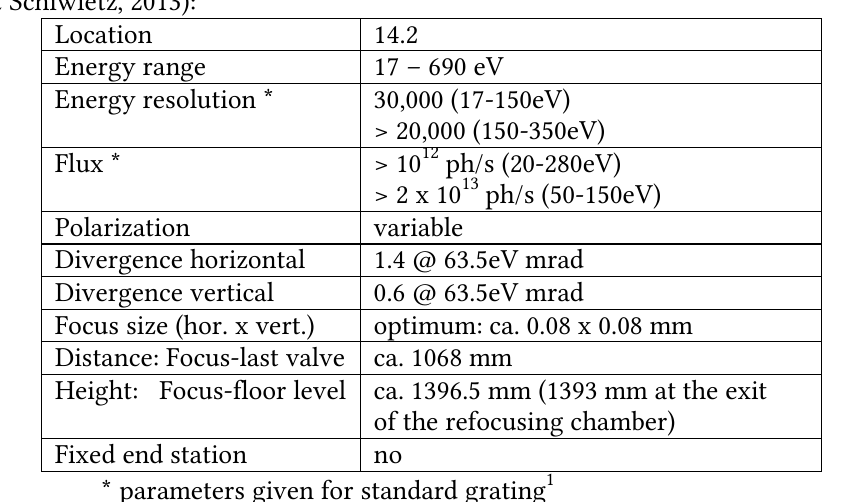
Table 2: Instrument-data table: technical summary on the undulator/monochromator combination.